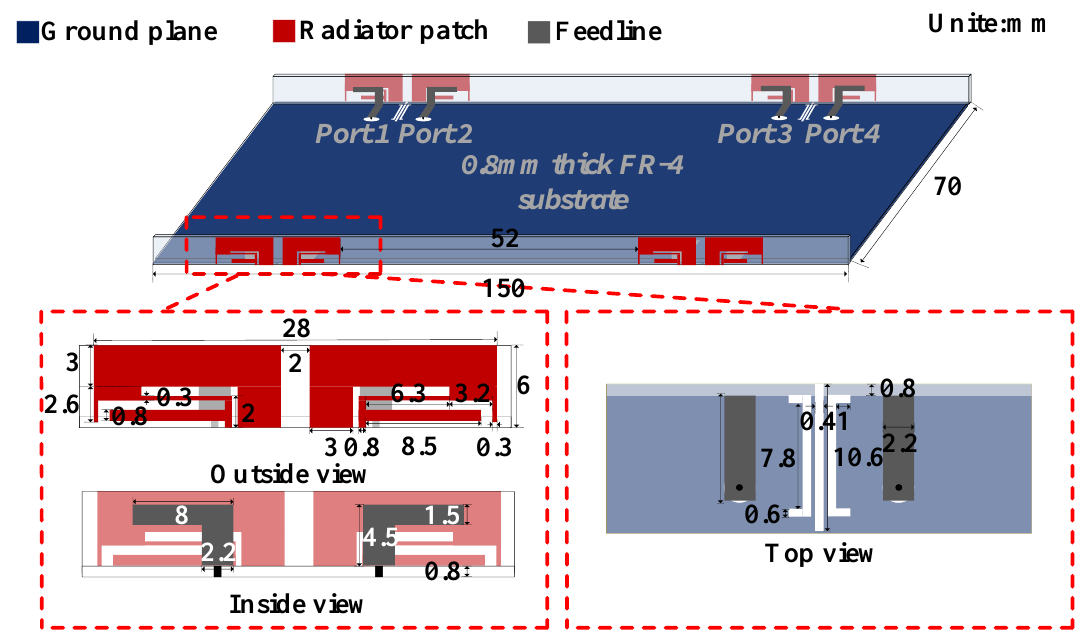
Figure 1. Configurations of the proposed antenna pair.